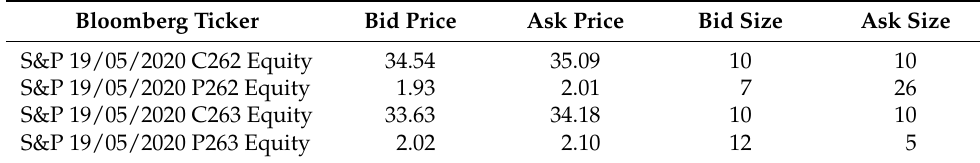
Table 1. Taken from Bloomberg terminal on the 19 May 2020 at 12:00:01 Bangkok time. Bloomberg